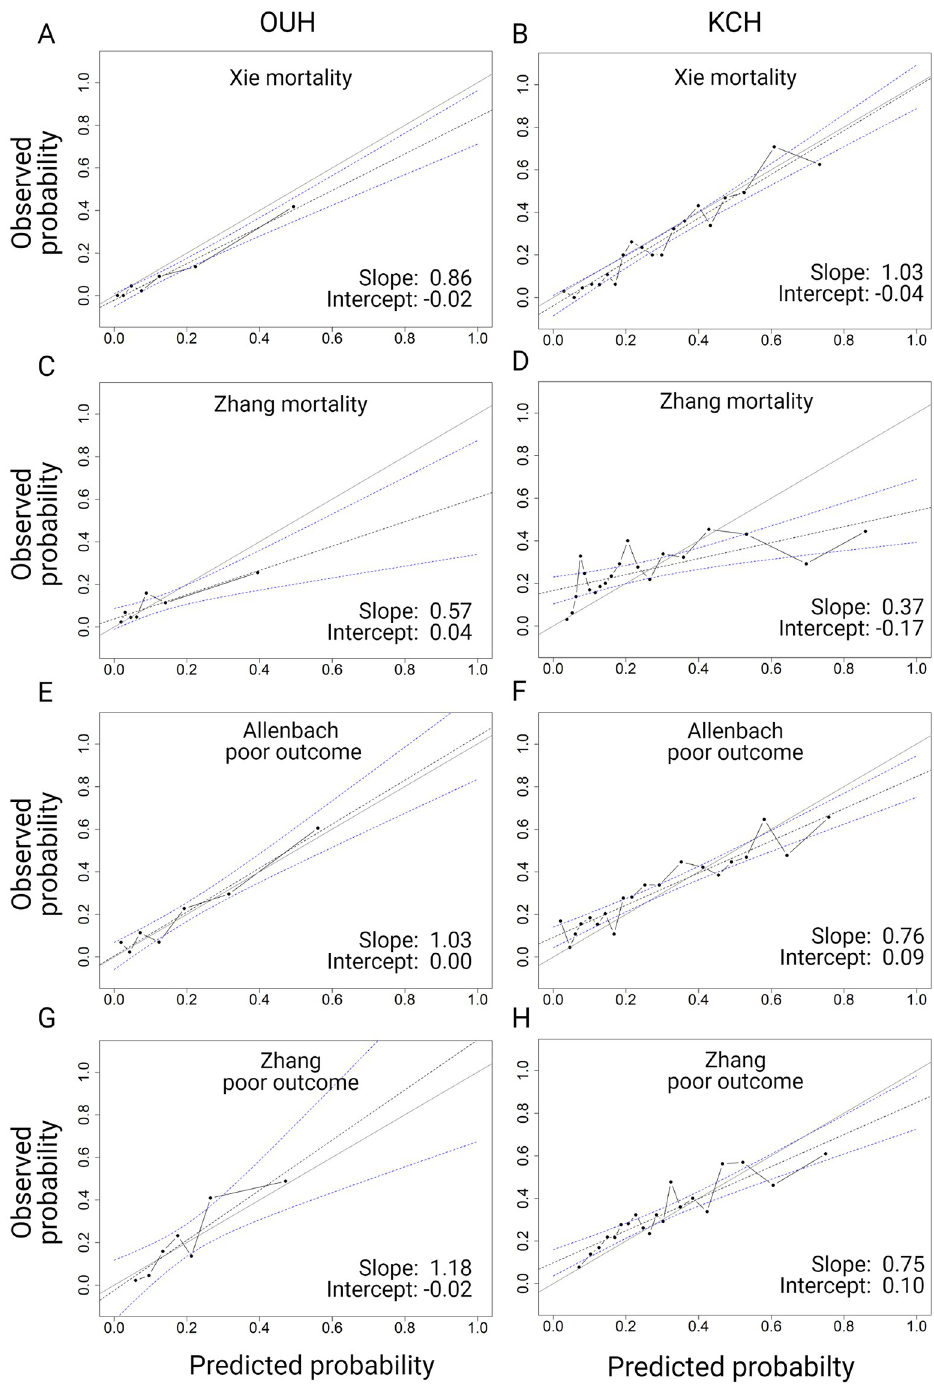
Fig 3. Calibration plots for OUH and KCH after recalibration.